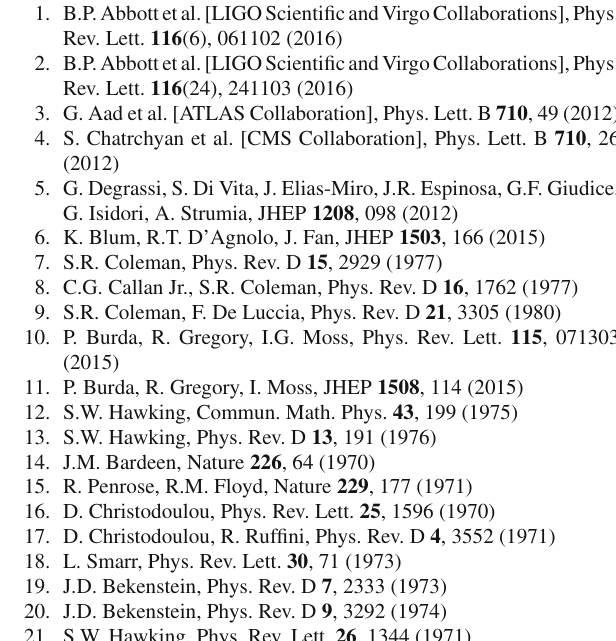
( a ) The bounds under M 1 = 1, a 1 = 0 . 2, g 2 = 0 . 2, M 2 = 1, and a 2 = 0 . 2. Fig. 17 The upper bounds on the radiation with respect to ρ and g Q 1 + Q 2 = Q 3